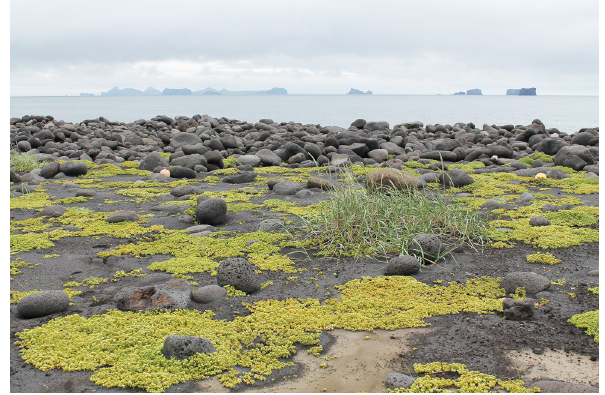
Fig. 2. Surtsey seabird colony with dense grass-dominated vegeta- tion (Photo: BM 2013).